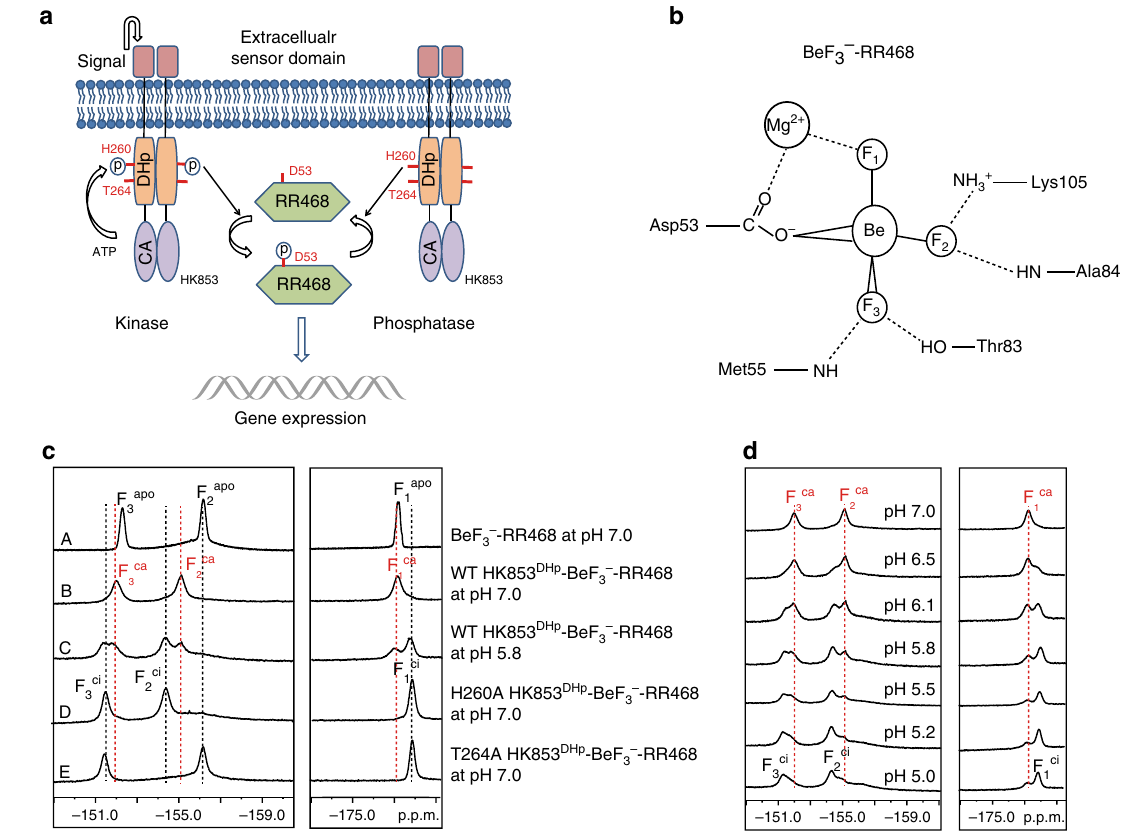
Fig. 1 19 F NMR studies reveal multiple conformational states of the HK853-BeF 3 − -RR468 protein complex. a The signal transduction pathway of the two- component system, exempli fi ed by the bifunctional histidine kinase, HK853, and the downstream response regulator, RR468. b A schematic illustration of the coordination of BeF 3 − in the active site of BeF 3 − -RR468 (PDB 3GL9). c The 19 F NMR spectra of BeF 3 − -RR468 without and with HK853 DHp and mutants: spectrum A, BeF 3 − -RR468 at pH 7.0; spectrum B, the wild-type HK853 DHp -BeF 3 − -RR468 complex at pH 7.0; spectrum C, the wild-type complex at pH 5.8; spectrum D, the H260A HK853 DHp -BeF 3 − -RR468 complex at pH 7.0; spectrum E, the T264A HK853 DHp -BeF 3 − -RR468 complex at pH 7.0. Fluorine signals of apo BeF 3 − -RR468, the catalytically active HK853 DHp -BeF 3 − -RR468 complex, and the catalytically inactive HK853 DHp -BeF 3 − -RR468 complex are labeled as F apo , F ca , and F ci , respectively. d The 19 F NMR spectra of the wild-type HK853 DHp -BeF 3 − -RR468 complex at different pH